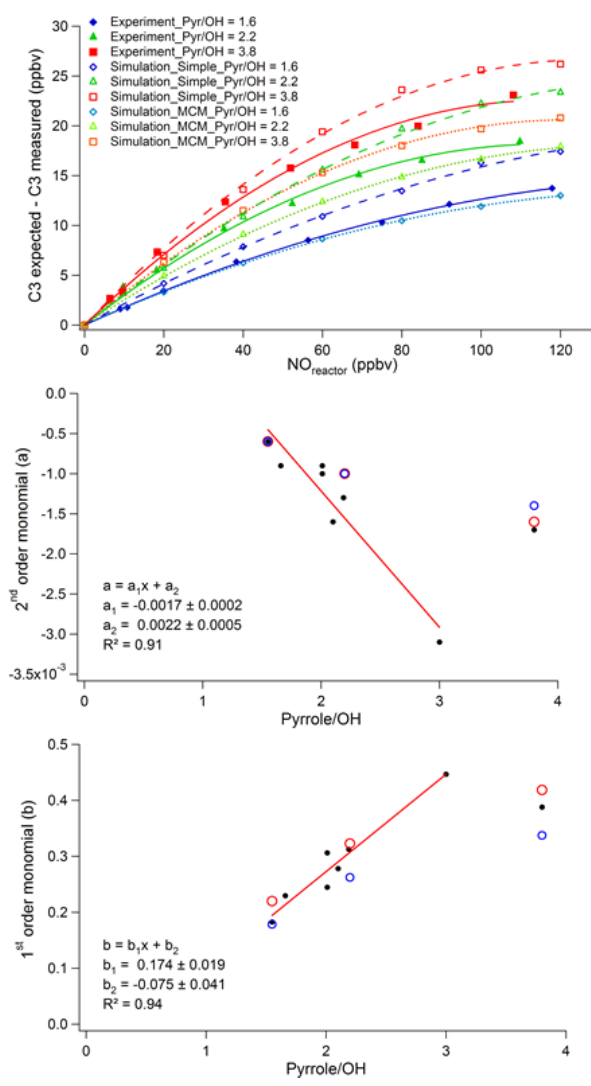
Figure 5. Comparison of model simulations to laboratory obser- vations for the NO artifact. Top panel: experimental (filled sym- bols and solid lines) and simulated (open symbols) results. The dashed and dotted lines are for the simple mechanism and MCM, respectively. Changes in C3 ( (cid:49) C3 = C3 expected − C3 measured) are shown as a function of NO in the CRM reactor. Experimental values are the same as in Fig. 3. Simulations were made at the same pyrrole-to-OH ratios as the experiments (same color code) and un- der dry conditions. Middle and bottom panel: experimental (black dots) and simulated (open circles) results. Red and blue circles are for the simple mechanism and MCM, respectively. These curves show the trends of the first- (bottom) and second-order (middle) monomials with the pyrrole-to-OH ratio for the quadratic regres- sions presented in the top panel. The red lines and the equations correspond to linear regressions adjusted in the experimental re- sults. The experiment performed using dry zero air (pyrrole-to-OH ratio of 3.9) is not included in the linear regressions (see